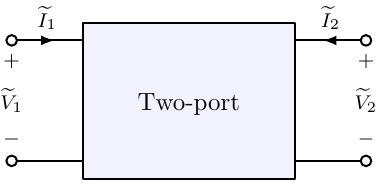
Figure 1. General two-port